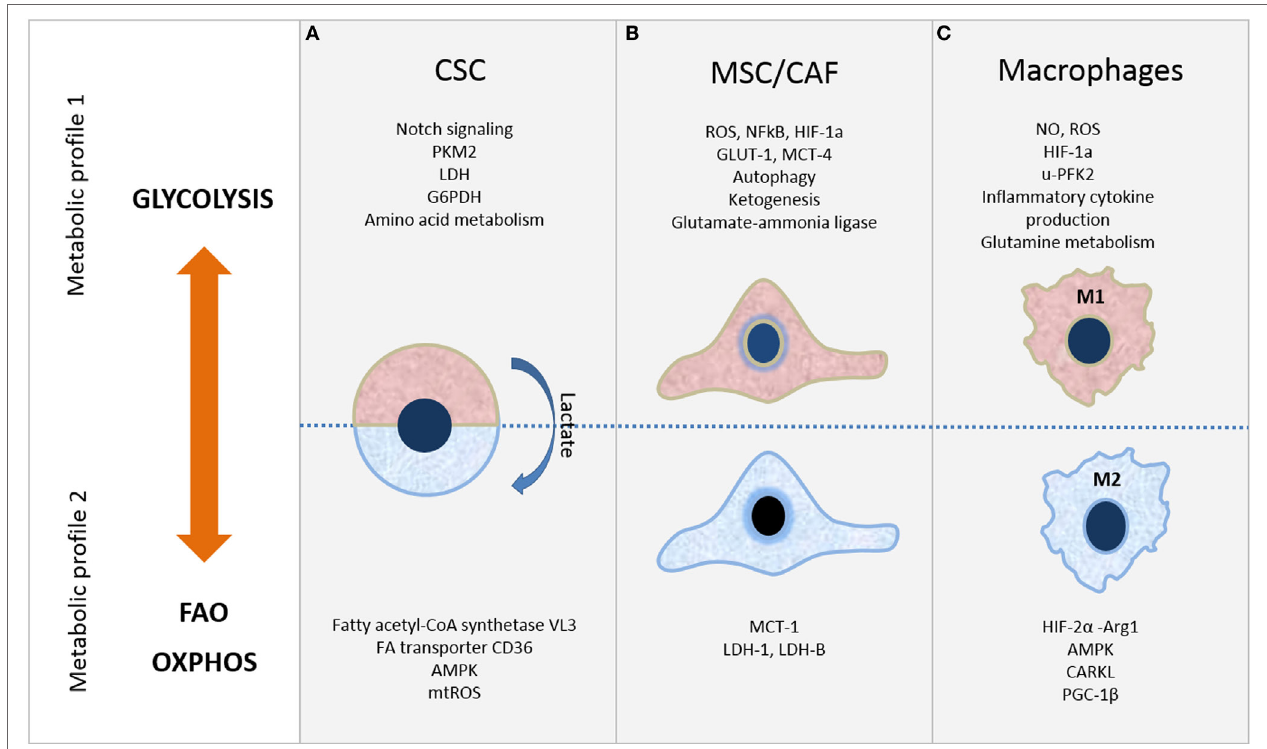
FigURe 1 | Metabolic plasticity of cells in tumor microenvironment. Selected metabolic features of (A) cancer stem cells (CSC), (B) mesenchymal stromal/stem cells (MSC)/cancer-associated fibroblasts (CAF), and (C) macrophages. Refer to the text for further details.